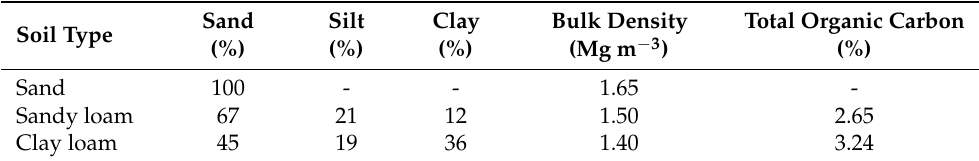
Table 1. Sand, silt, clay percentages, and bulk densities of three soils used in the study.